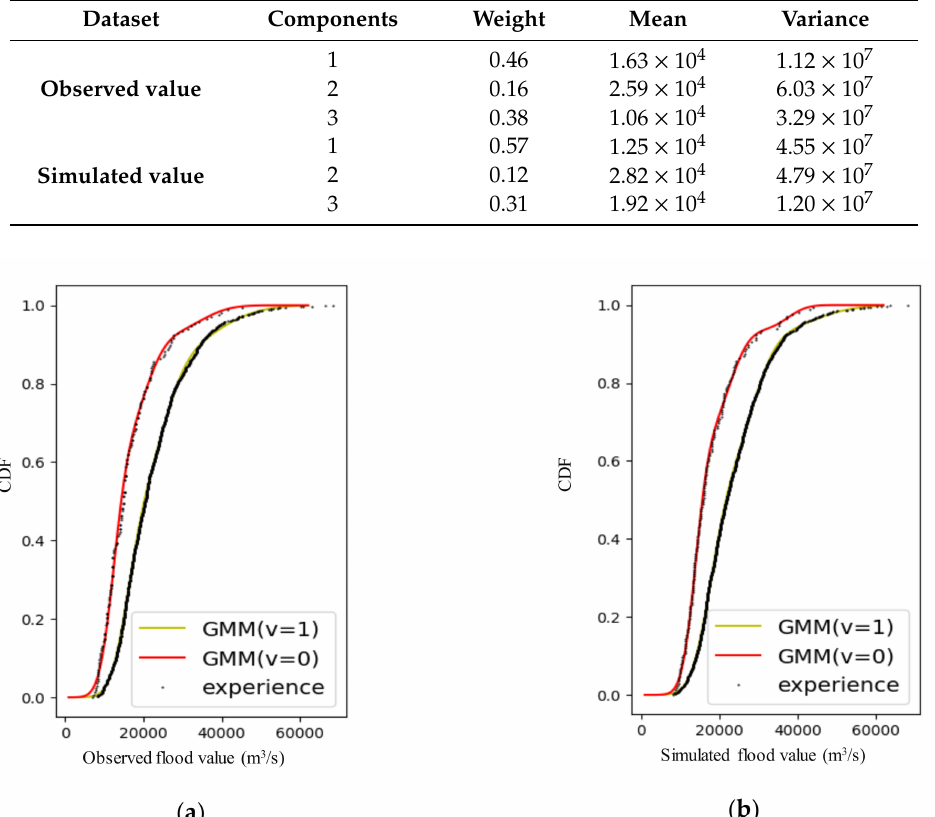
Figure 4. Fitting of the marginal CDF of observed value and simulated flood value. ( a ) Marginal CDF of observed value. ( b ) Marginal CDF of simulated value. GMM (v = 1) and GMM (v = 0), respectively, represent the fitting of the distribution function in the case of e ff ective rainfall and negligible rainfall.